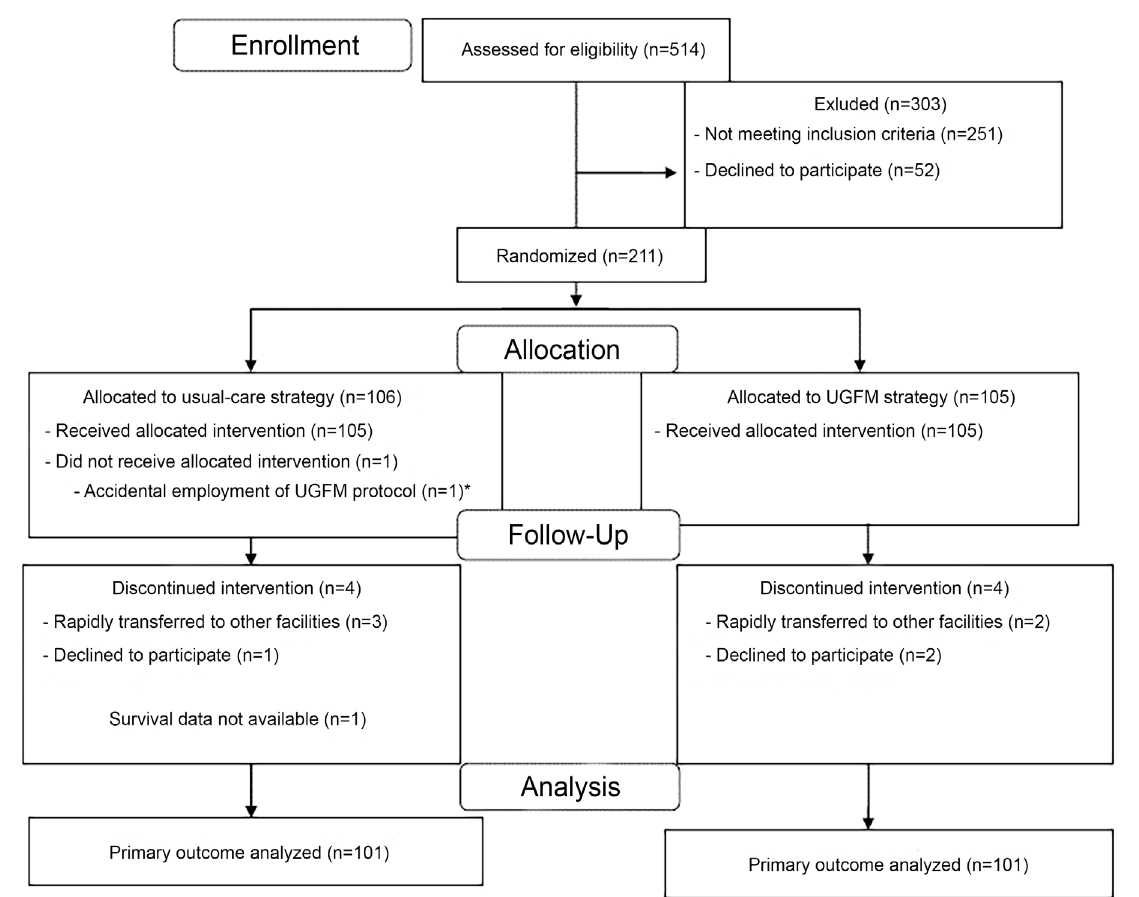
Figure 1. The CONSORT diagram demonstrating patient flow in both treatment groups. Reasons for patient exclusion are shown in Table S1 in the Supplemental